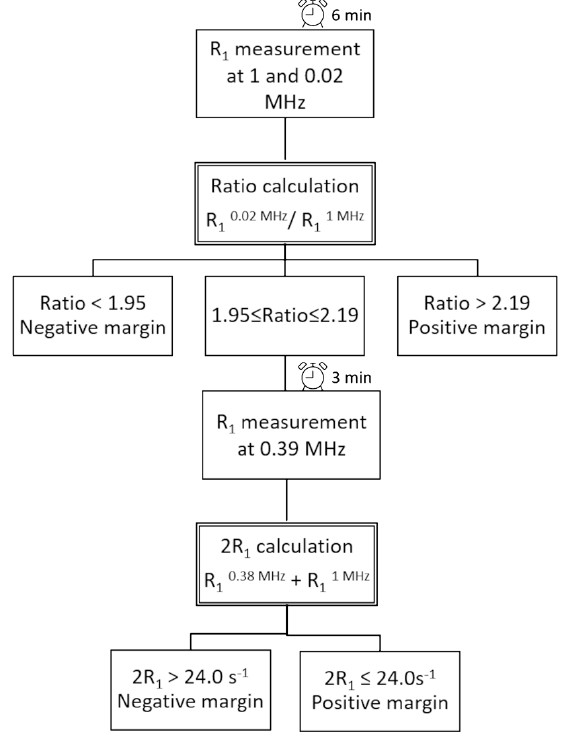
Figure 5. Schematic representation of the experimental procedure to evaluate margins from excised specimens.